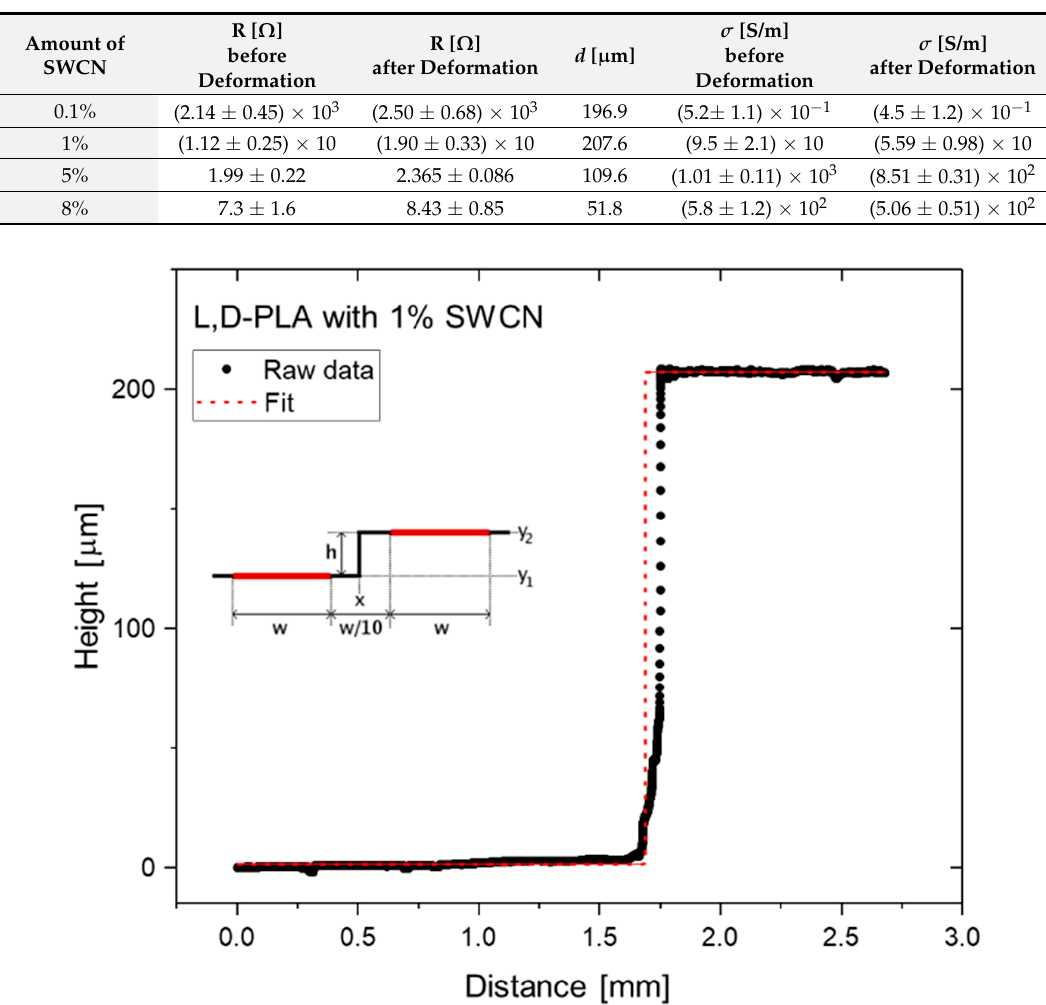
Figure 2. Topography profile (dots) obtained from profilometer measurements used for the determination of L , D -PLA with the 1% SWCN sample thickness by fitting edge function (dashed line): y 1 and y 2 are baselines, and h is the resultant thickness.